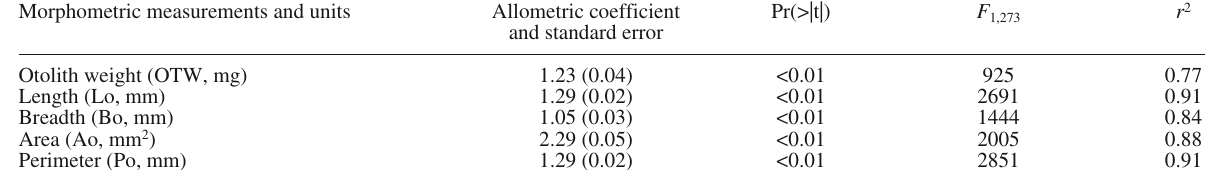
Table 2. – Allometric coefficient for each morphometric measurements of Strangomera bentincki otoliths as a function of total body length (cm). Morphometric measurements and units Allometric coefficient